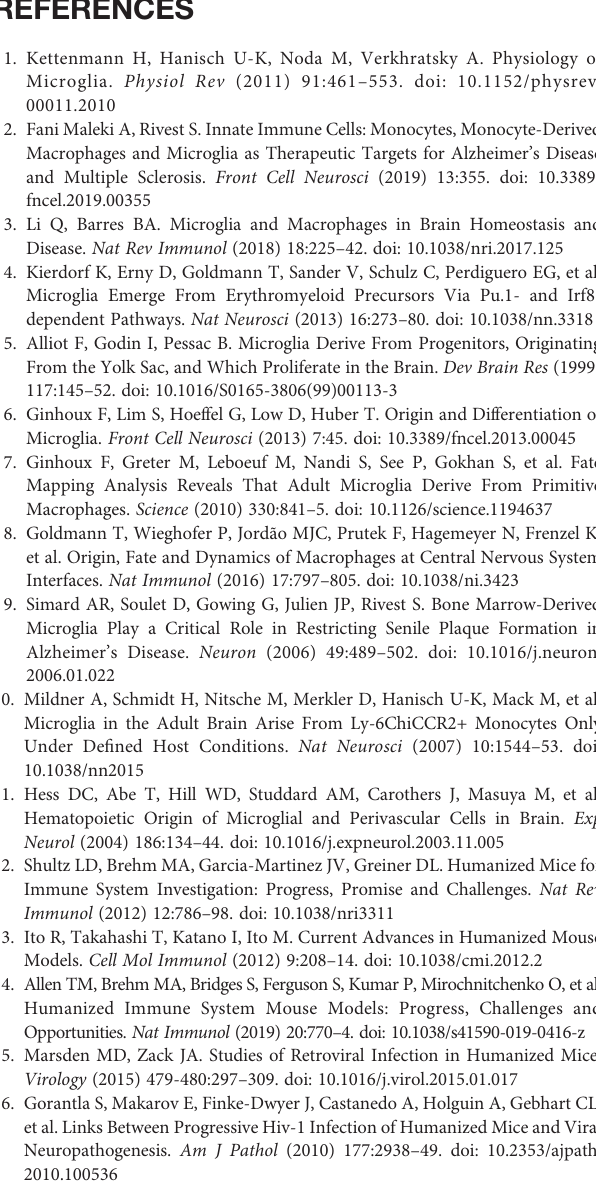
Supplementary Figure 1 | The hIba-1+ myeloid cell reconstitutions in the spinal cord and cerebellum tissues of hu-BLT-hIL-34 and hu-BLT mice. The upper panel Supplementary Figure 2 | The comparison of human myeloid cell reconstitutions in the cortex, corpus striatum, hippocampus, and cerebellum